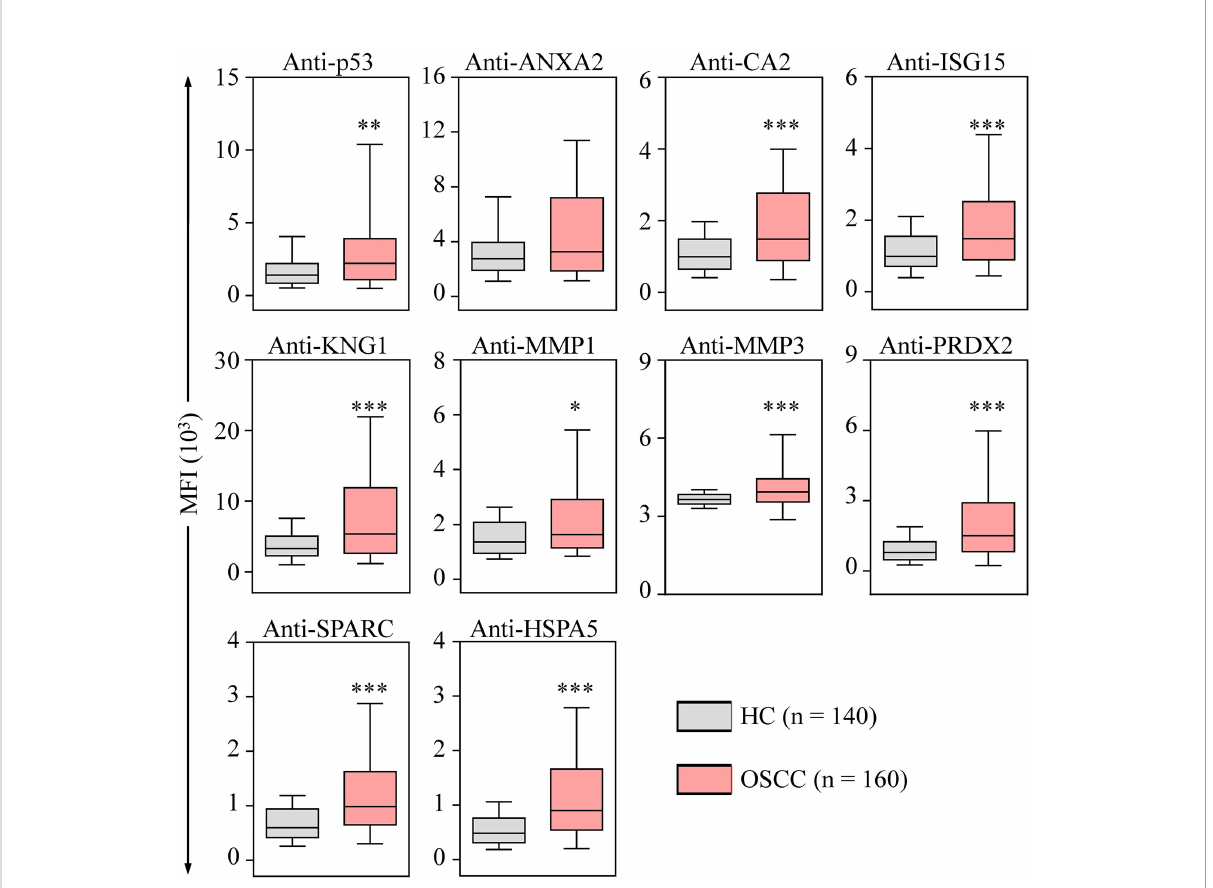
FIGURE 4 Elevated levels of salivary auto-Abs in the OSCC patients. The levels of auto-Abs were detected in saliva samples respectively collected from healthy controls (HC; n = 70), and OSCC patients ( n = 80) with the multiplexed bead-based system. Salivary levels of the auto-Abs are shown with the median fl uorescence intensity (MFI). Data are presented as the upper and lower quartiles (box), the median value (the horizontal line), and the middle 90% distribution (the whisker) of MFI. * p < 0.05, ** p < 0.01 and *** p <